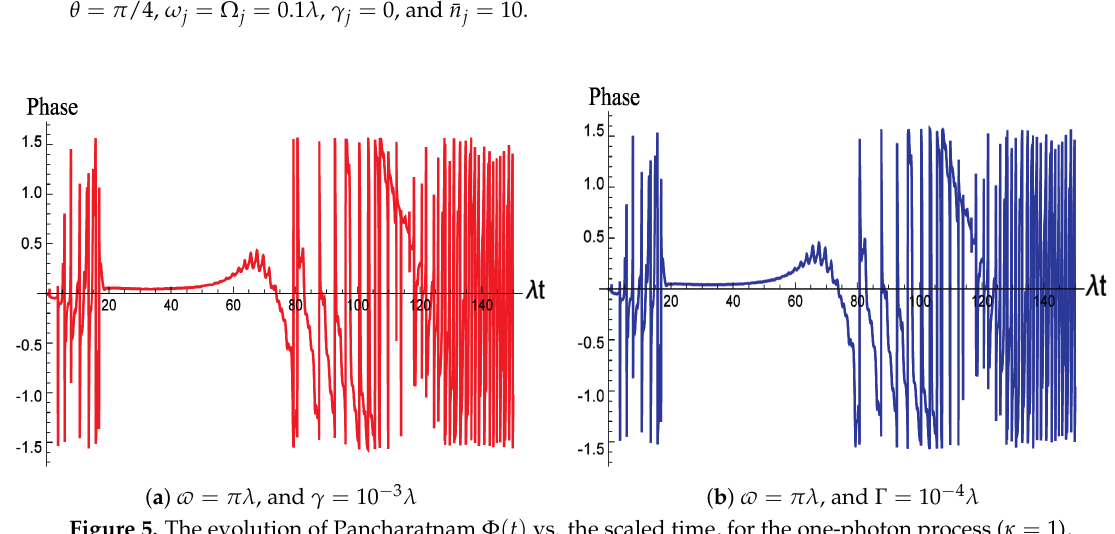
Figure 5. The evolution of Pancharatnam Φ ( t ) vs. the scaled time, for the one-photon process ( κ = 1), θ = π , ω j = Ω j = 0.1 λ , and ¯ n j = 4